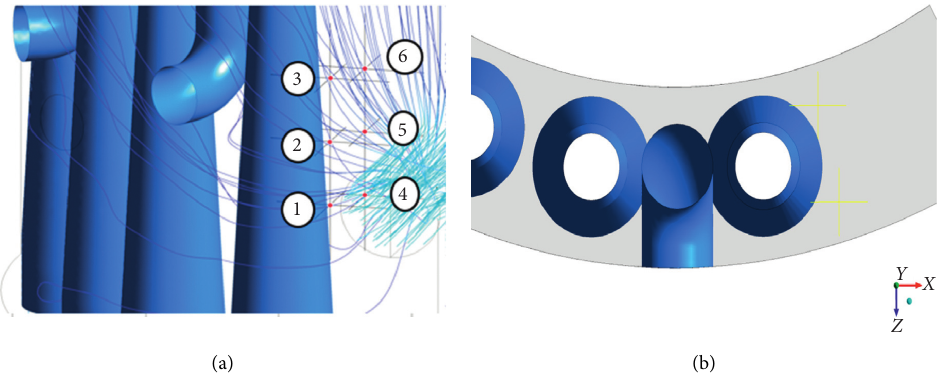
Figure 10: Points of monitoring. (a) Isometric view and (b) Plant